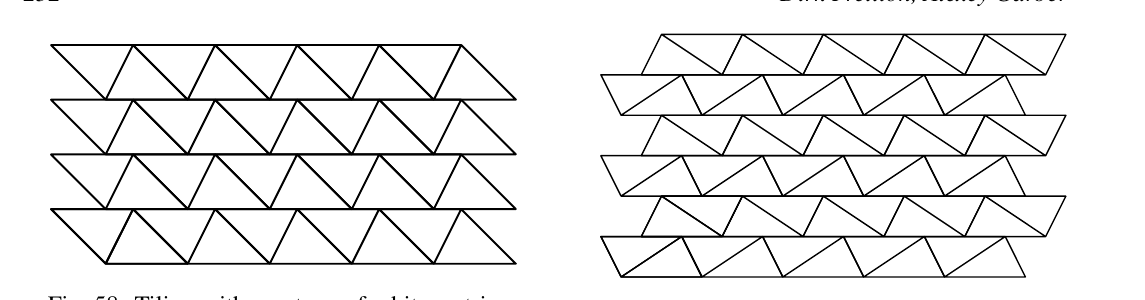
Fig. 58: Tiling with one type of arbitrary trian- gle (D).